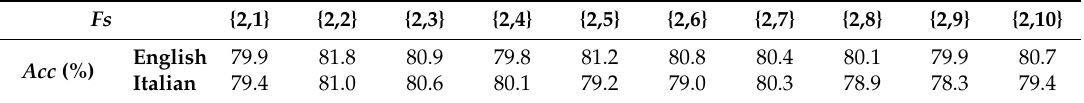
Table 9. Testing accuracy obtained by different filter sizes 1 .